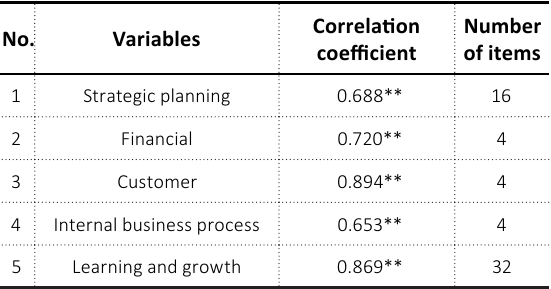
Table 2. Internal validity